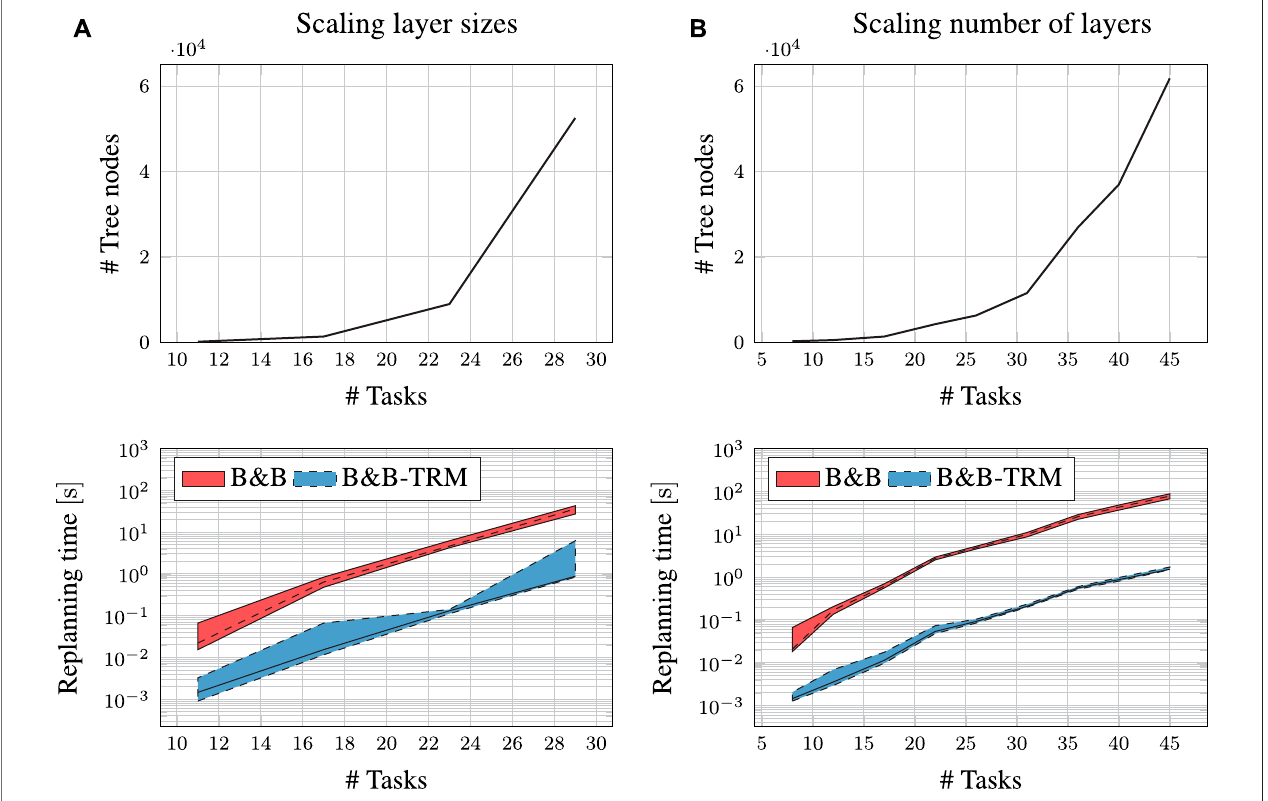
FIGURE 8 | Scalability experiments for Scenario A. ‘ #Tasks ’ indicates the number of tasks in the RTSG. ‘ #Tree nodes ’ indicates the number of nodes in the Task Roadmap search tree.